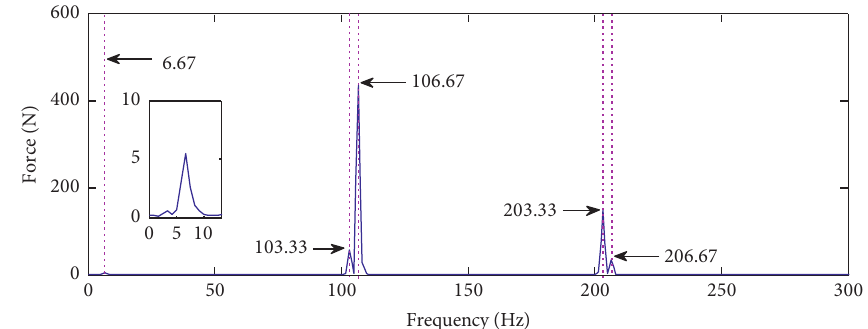
Figure 8: Meshing force spectrum of s- p